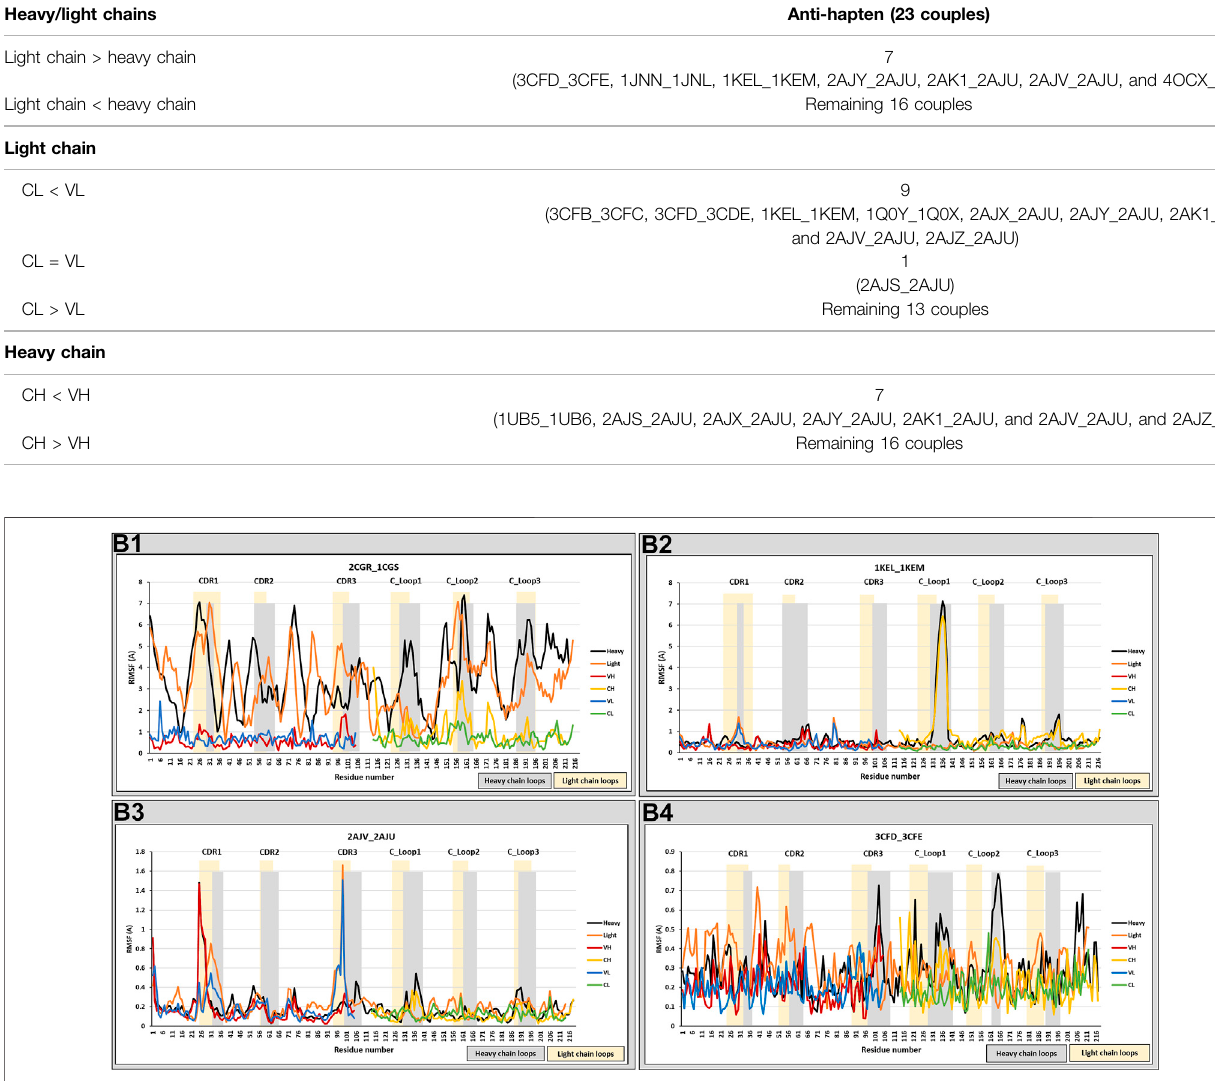
TABLE 1 | RMSD comparison.